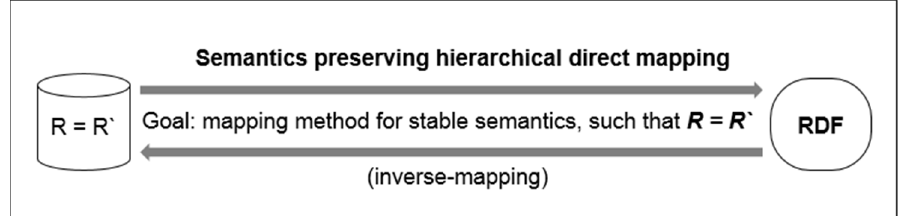
Figure 3. Overview of our direct-mapping method.